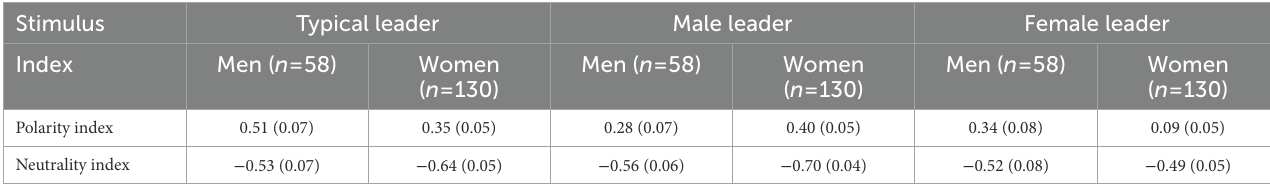
TABLE 1 Estimated marginal means and standard errors of polarity indices and neutrality indices for the stimuli “typical leader,” “male leader,” and “female leader” by participants’ gender.